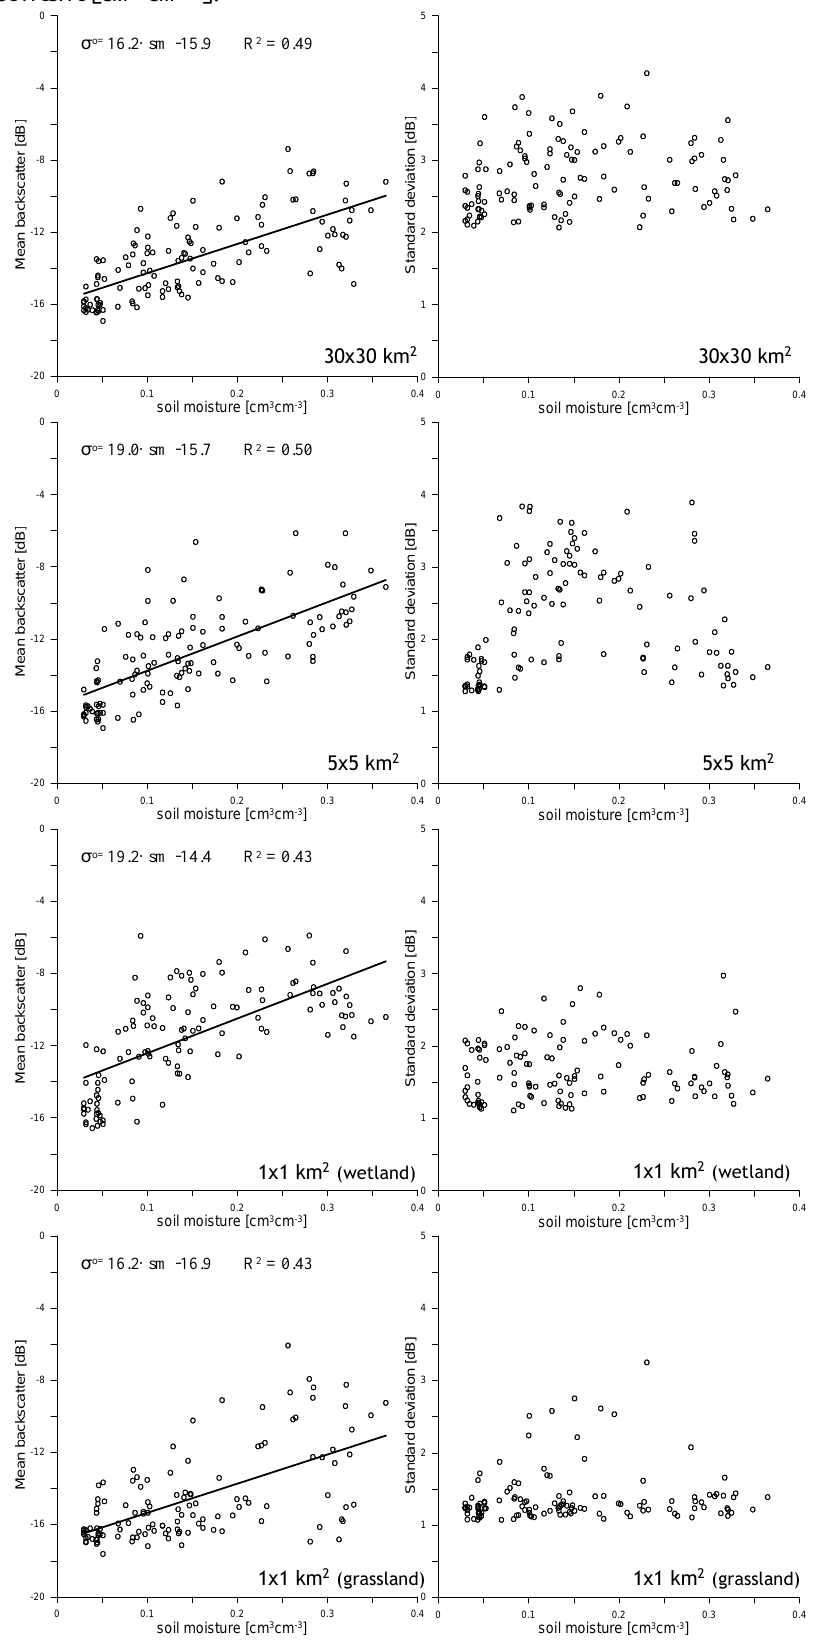
Figure 5. Comparison of the mean σ o and stdev with soil moisture measured at Naqu station for the four selected spatial domain. The lines in the plots with the mean σ o values represent linear regression functions of the form s = (cid:215) + o a sm b , where sm is the soil moisture content [cm 3 cm -3 ]. σ o= 16.2 · sm -15.9 R 2 =